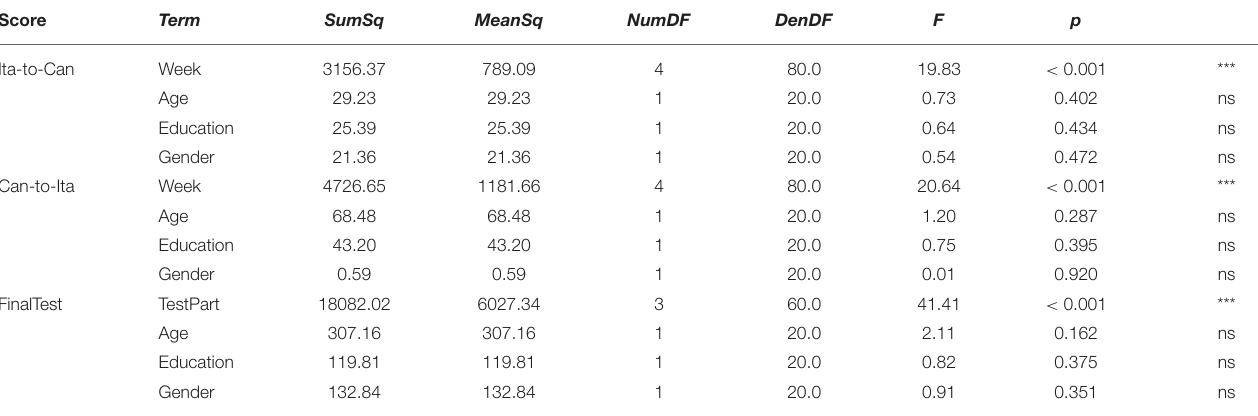
TABLE 3 | Demographic models for the in-class quizzes (Ita-to-Can and Can-to-Ita) and the final